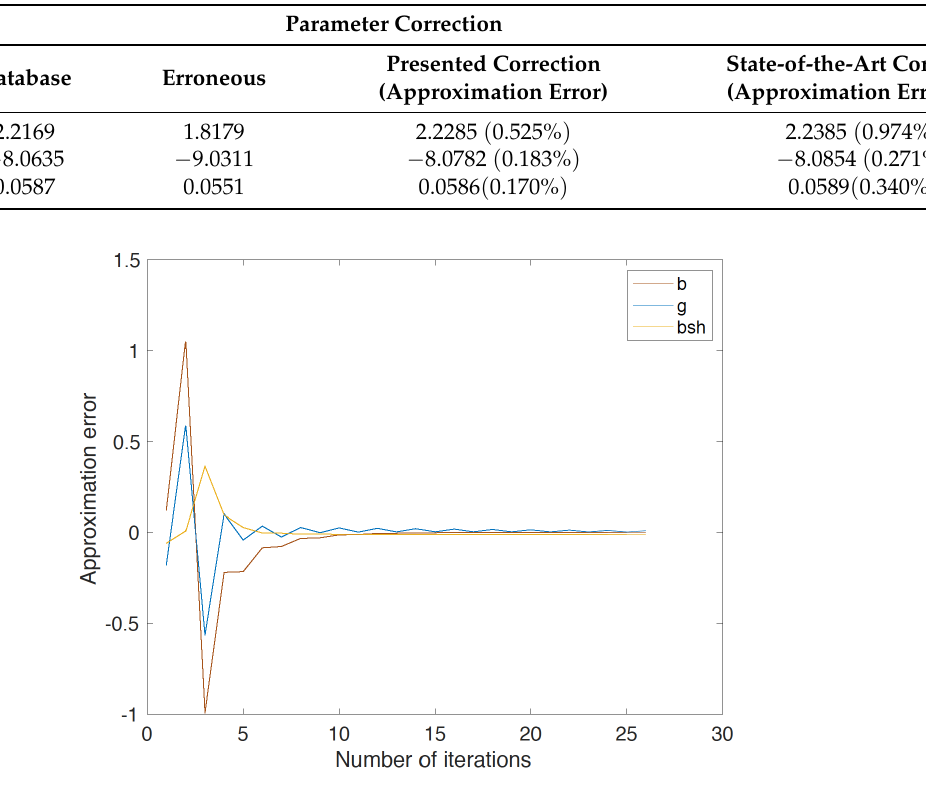
Figure 3. Correction for line 23–32 using presented model